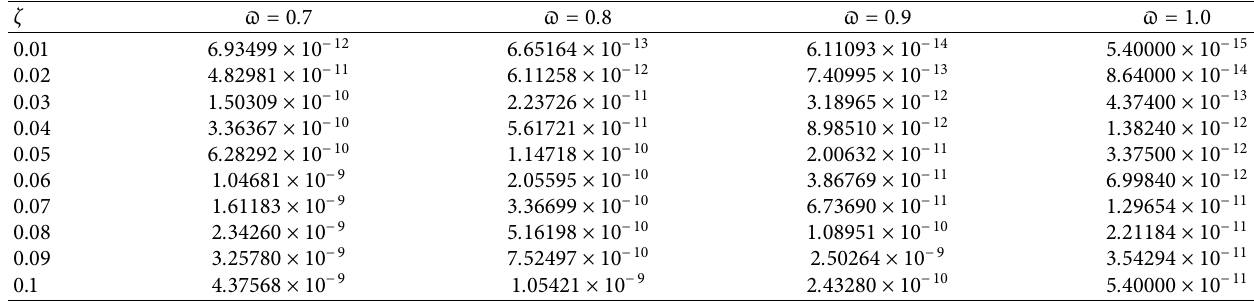
Table 3: | w 4 ( ϰ , ζ ) − w 3 ( ϰ , ζ )| of Problem 2 at diferent values of ϖ at ϰ � 1 . 0 determined by LRPSM at plausible locations in the range ζ ∈ [ 0 , 0 . 1 ] .